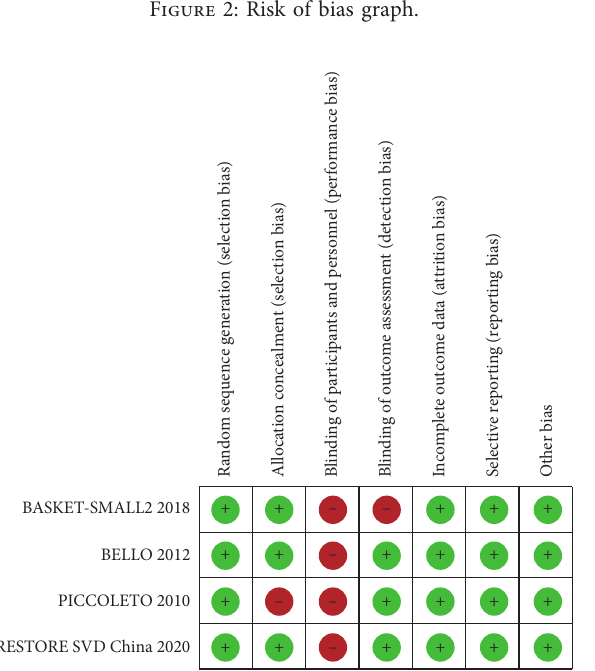
Figure 2: Risk of bias graph.